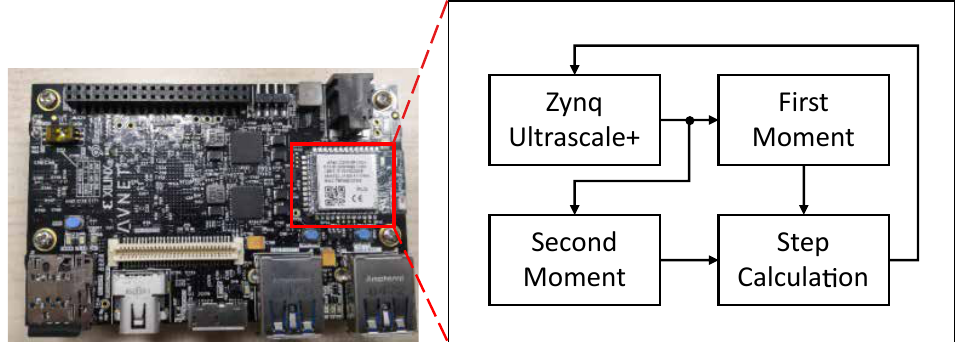
Figure 6. Hardware implementation of the proposed